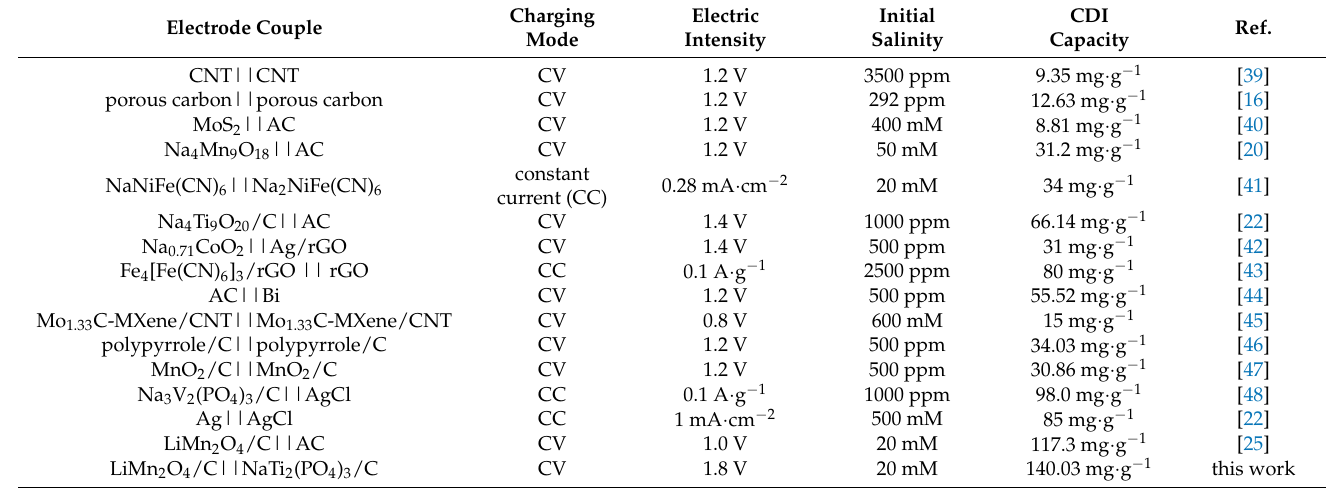
Figure 4. ( a ) The configuration of the CDI cell with dual-ion battery electrodes; ( b ) the deionization capacities of different voltages in the dual-ion desalination cell with the initial salinity of 10 mM; ( c ) the corresponding salt removal rates; ( d ) the desalination capacities with different initial salt concentrations. Table 1. A comparison of the desalination performances of electrode couples in the literature and our